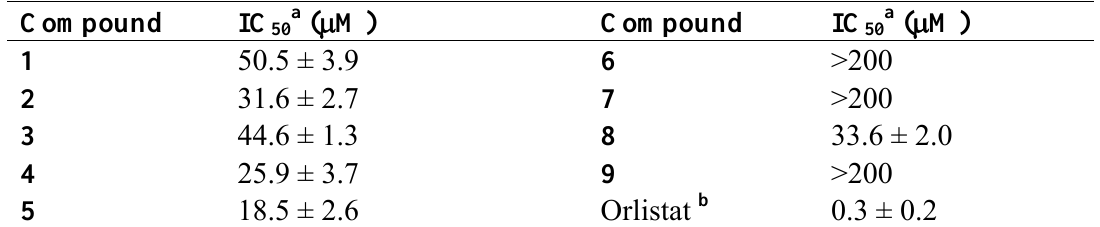
Table 2. Pancreatic lipase inhibitory activity of compounds 1 – 9